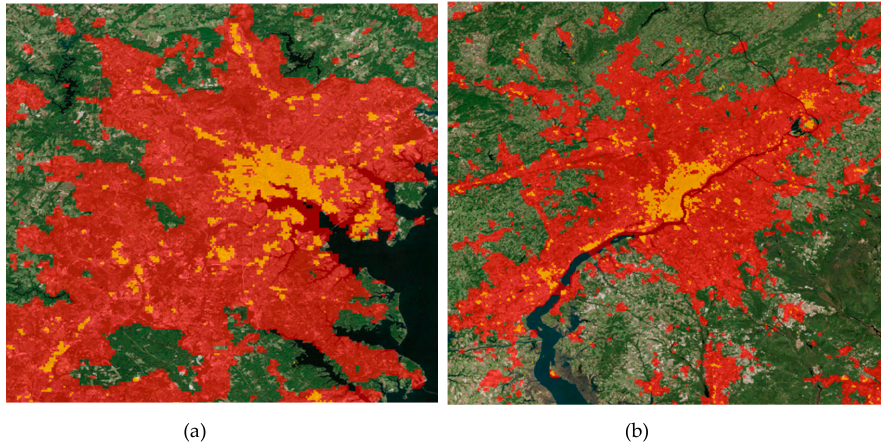
Figure 8. Comparison between 2015 urban extent generated by NN (Red) and GlobCover-extracted urban extent 2009 (Yellow), with the background imagery from 2017: ( a ) Baltimore; ( b )